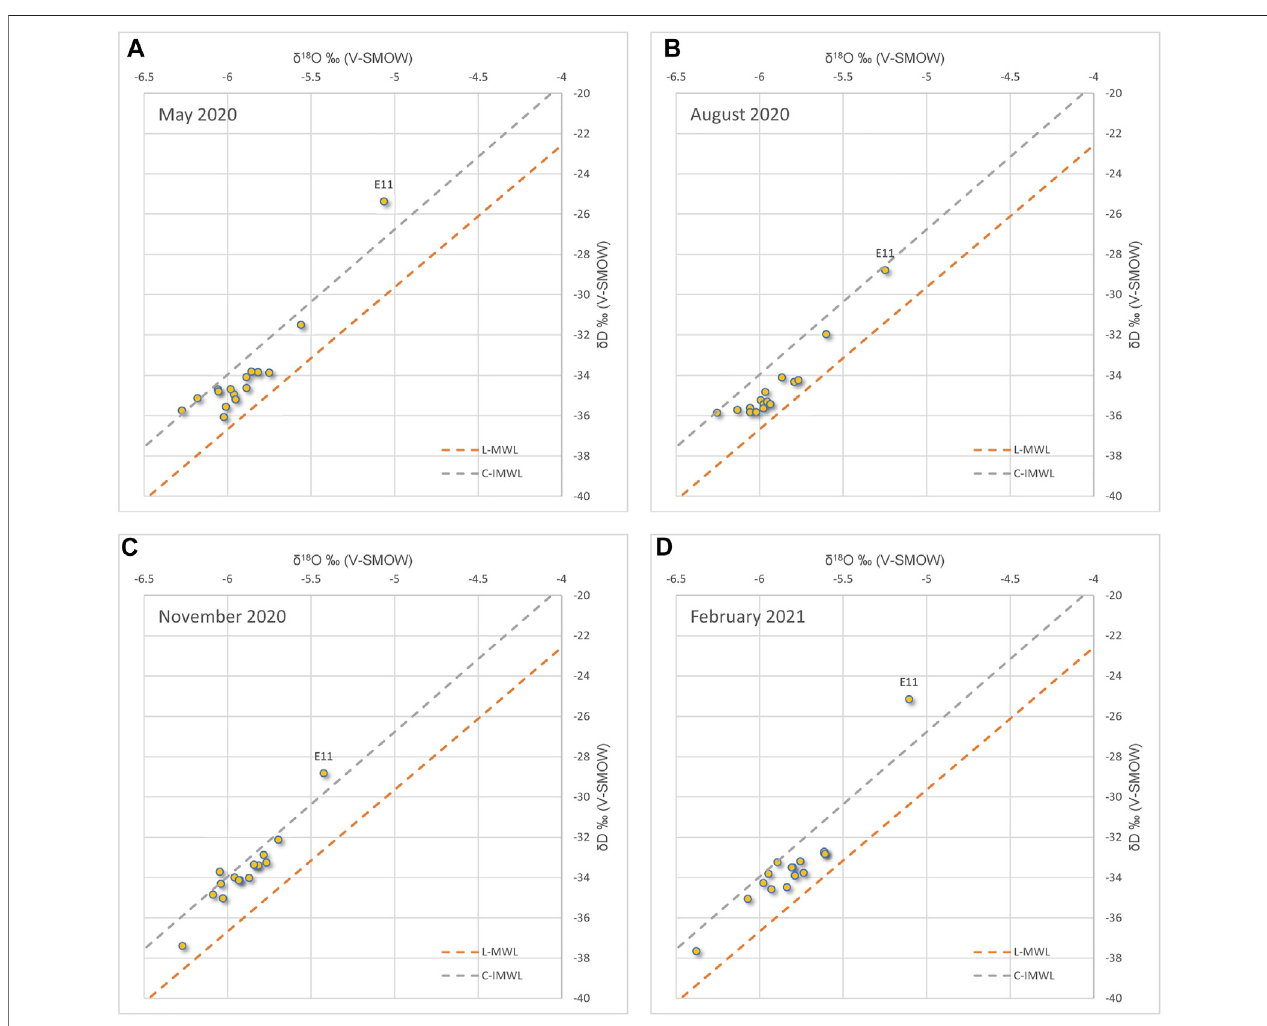
FIGURE 8 | δ 18 O- δ D plot of May 2020 (A) , August 2020 (B) , November 2020 (C) , February 2021 (dD) sampling surveys. L-MWL represents the Latium region Meteoric Water Line (orange dashed line, Bono et al., 2005); C-IMWL represents the Central Italy Meteoric Water Line (gray dashed line, Longinelli and Selmo, 2003).